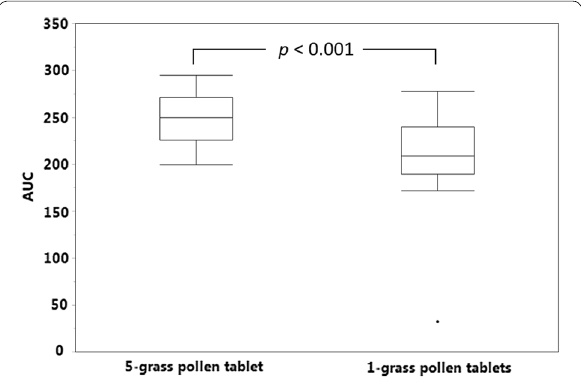
Fig. 2 AUCs obtained with one 5-grass pollen tablet and three 1-grass pollen tablets. AUCs were obtained in ELISA-inhibition experiments using microtiter plates coated with a 12-grass pollen extract and detection of serum IgE from Spanish patients ( n The p -value was obtained with the two-sided Wilcoxon signed rank test